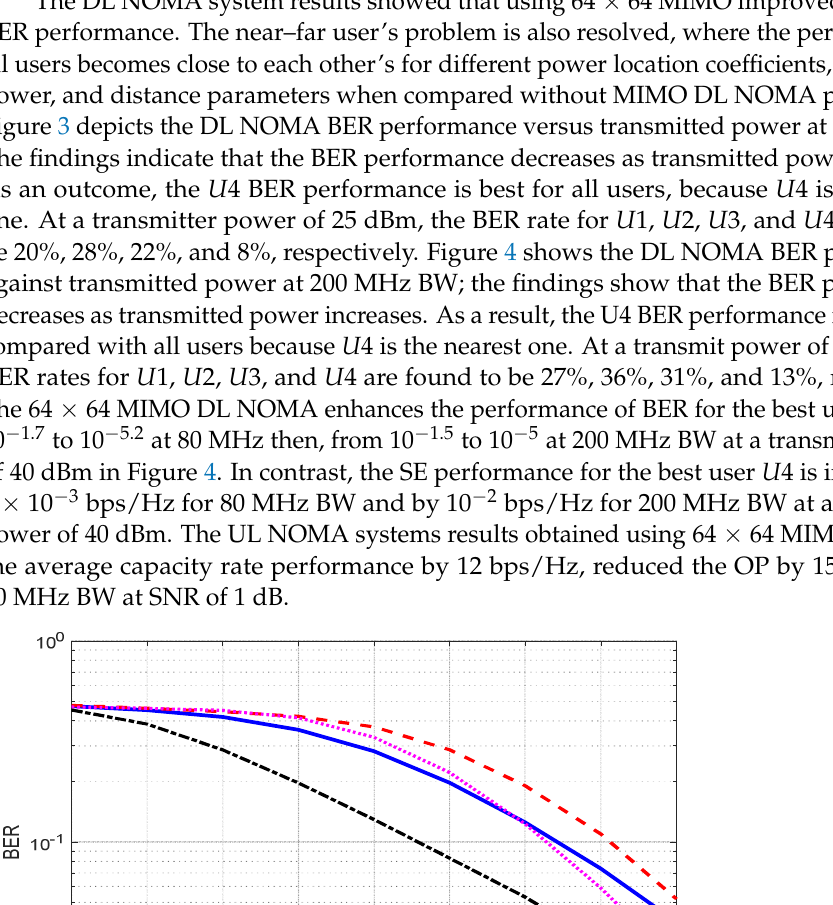
Figure 4. BER against transmitting power for four users with varying distances and power coeffi- cients, for DL NOMA at BW (200 MHz). At 80 MHz BW and 64 × 64 MIMO, Figure 5 shows the DL NOMA BER performance versus transmitted power. When transmitted power is 20 dBm, the BER rate for U1, U2, U3, and U4 is found to be 19 × 10 −4 , 18 × 10 −4 , 8 × 10 −4 , and 5 × 10 −4 , respectively. Figure 6 shows the DL NOMA BER performance against transmitted power at 200 MHz BW and 64 × 64 MIMO, at a transmitted power of 25 dBm, the BER rates for U1, U2, U3, and U4 are found to be 46 × 10 −4 , 43 × 10 −4 , 19 × 10 −4 , and 7 × 10 −4 , respectively. The MIMO system reduces the BER performance.